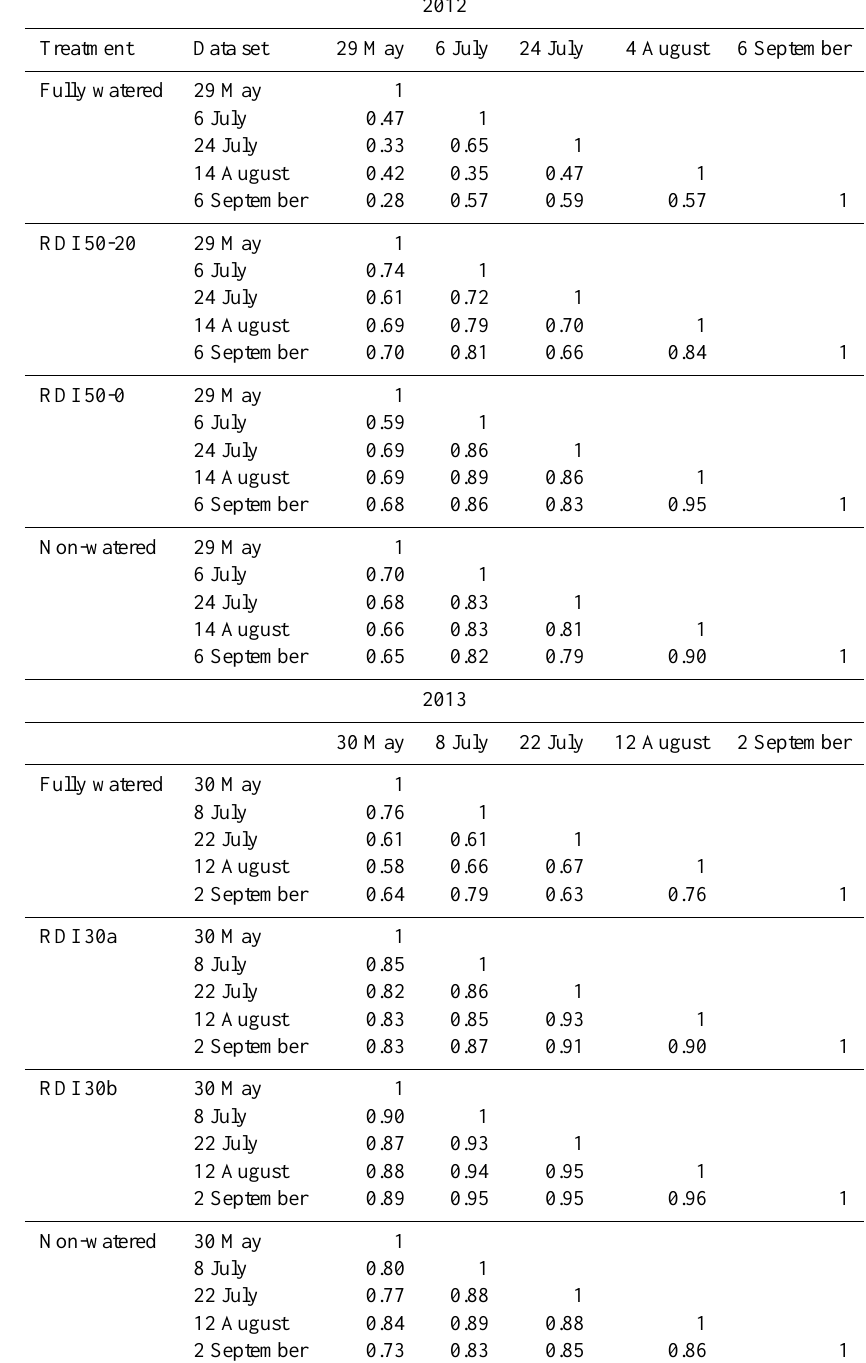
Table 8. Correlation matrices between 2012 and 2013 NDVI surfaces of each irrigation